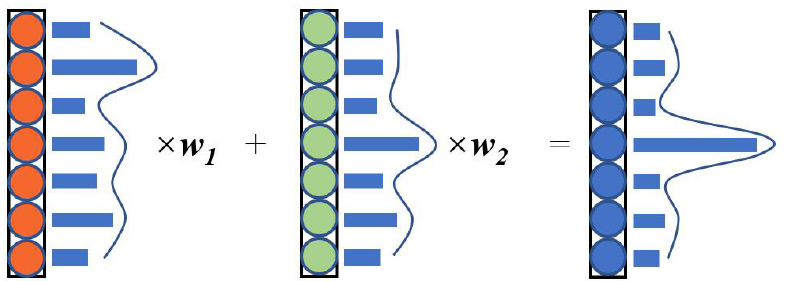
Figure 3. Multiple network fusion decision. When the probabilities of different categories are nearly equal, use a smaller value to multiply the vector. Otherwise, use a larger value to multiply the